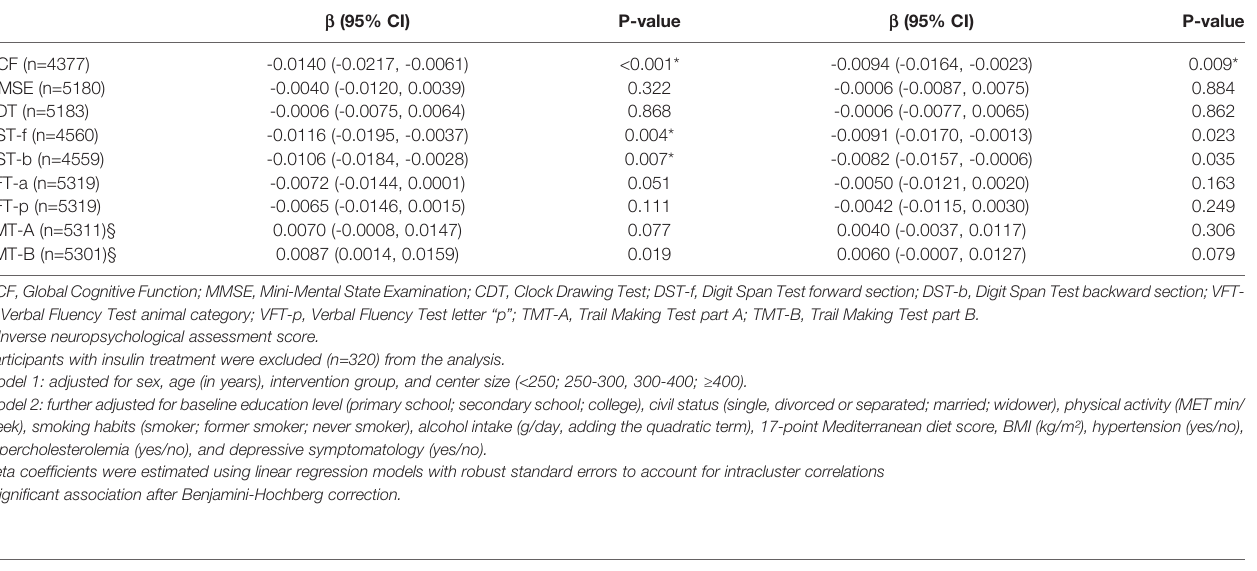
TABLE 3 | Association between baseline HOMA-IR levels (per one unit increment) and changes in cognitive Z-scores.